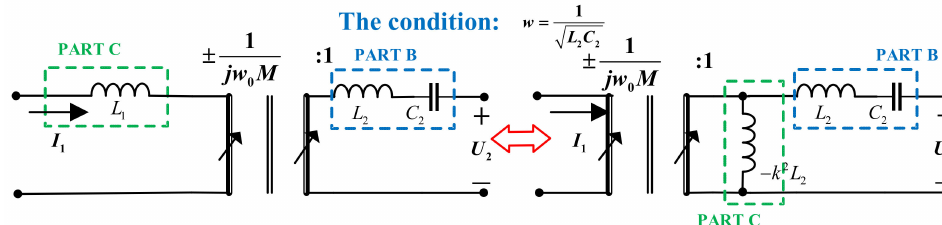
Figure 16. The equivalent model of the III_CC_CC circuit.